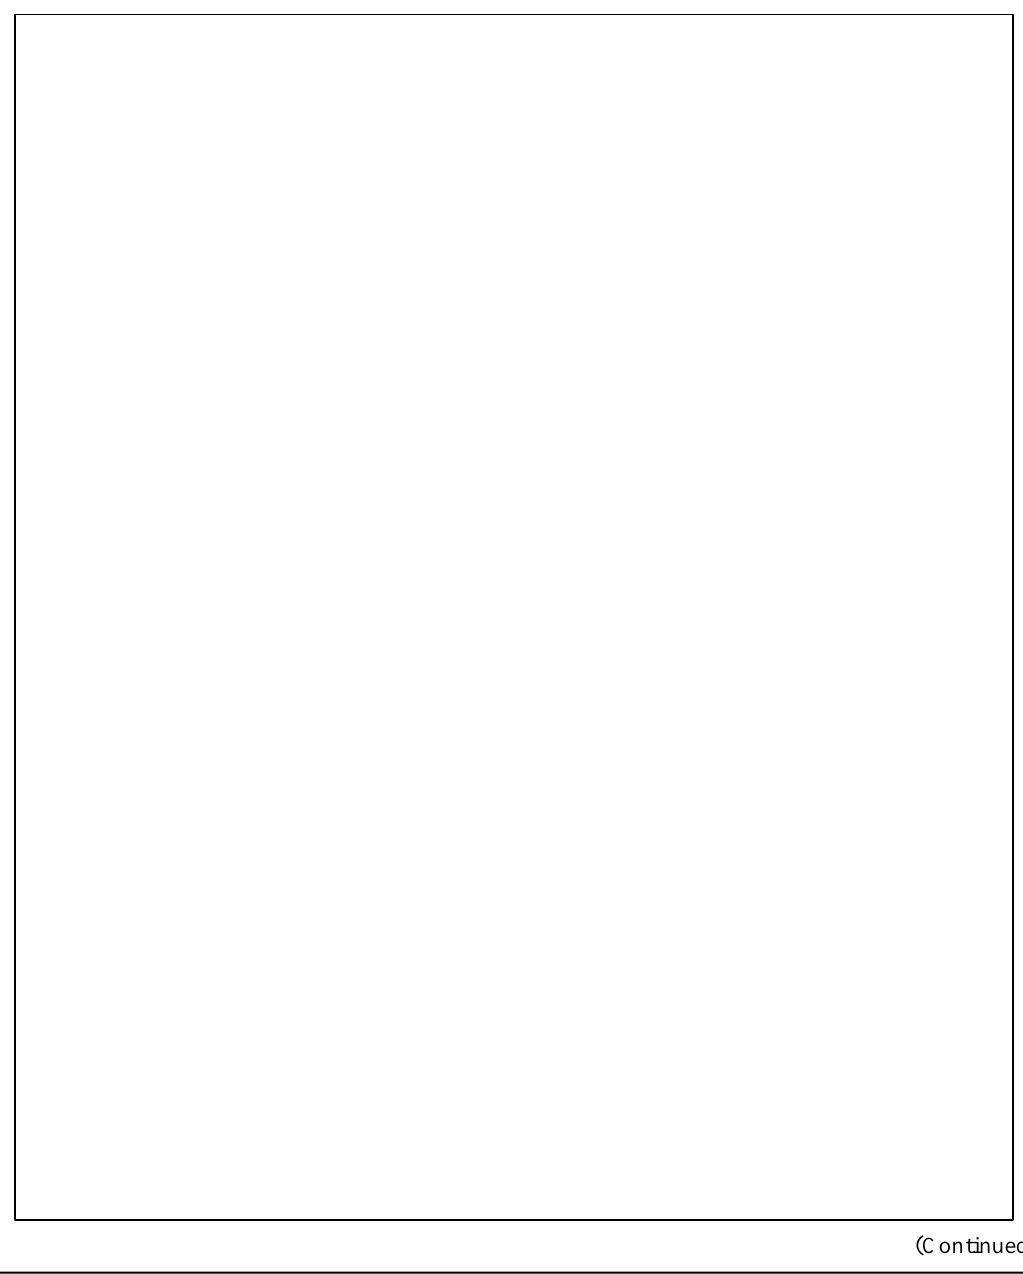
Table II: Pretest of the draft pamphlet on the visitors/caregivers (n=614) of patients admitted to TUTH wards: the questions asked, responses given, and subsequent revisions made in the